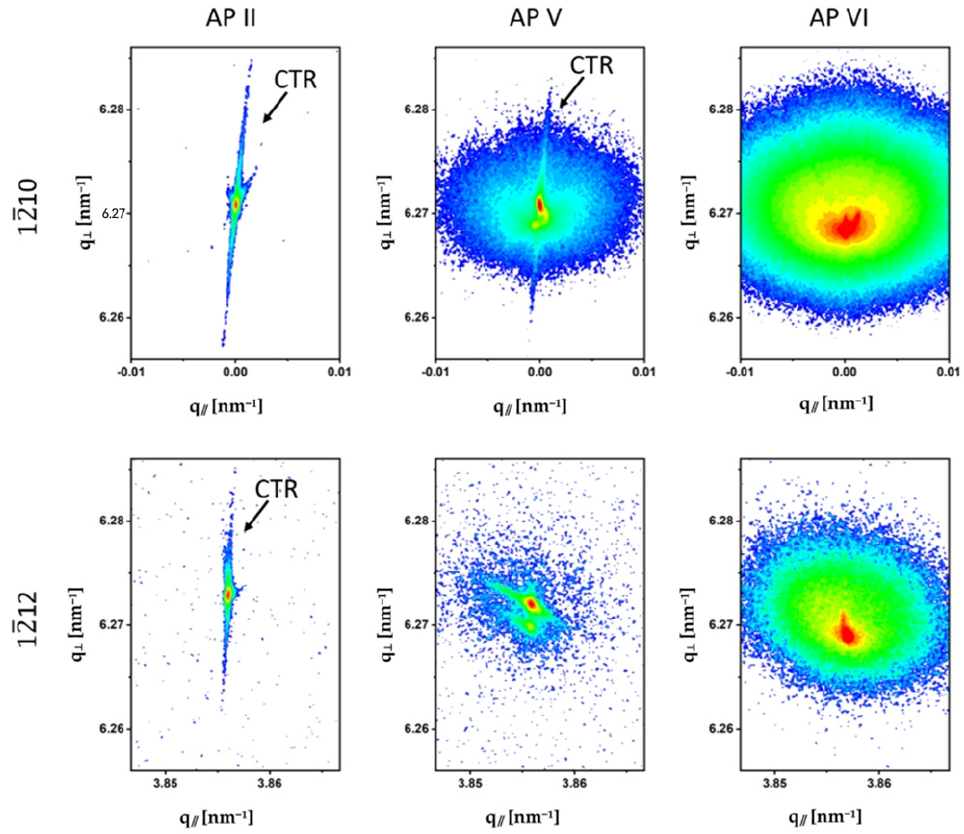
Figure 8. RSMs of the symmetrical 12(cid:3364)10 reflection and the asymmetrical 12(cid:3364)12 reflection performed on the (12(cid:3364)10) slice. Positions of the crystal truncation rods (CTRs) are indicated on the maps.